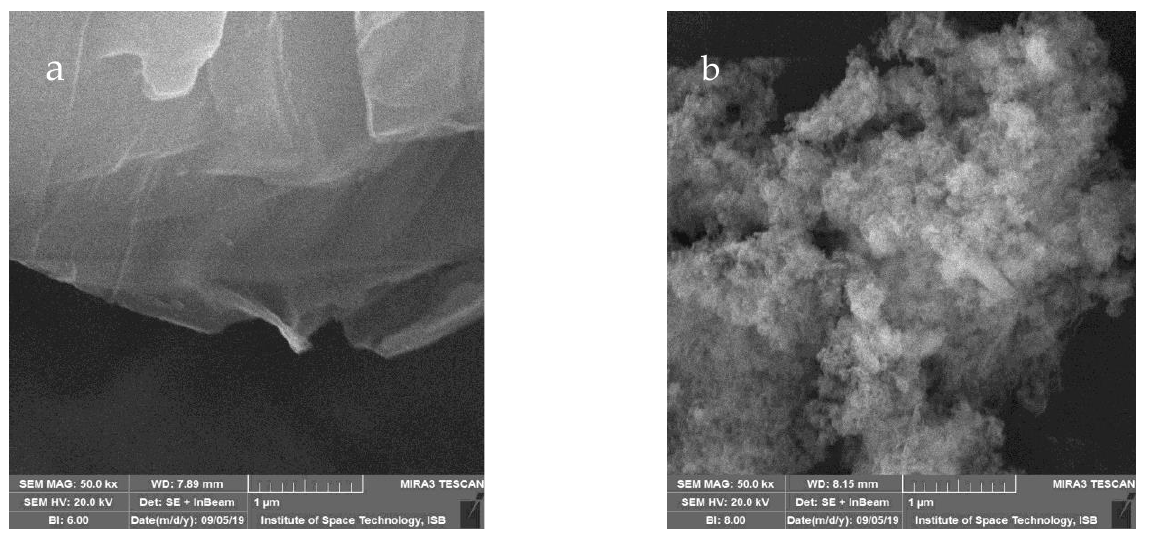
Figure 2. SEM images of GO ( a ) and rGO-ZnO ( b ).